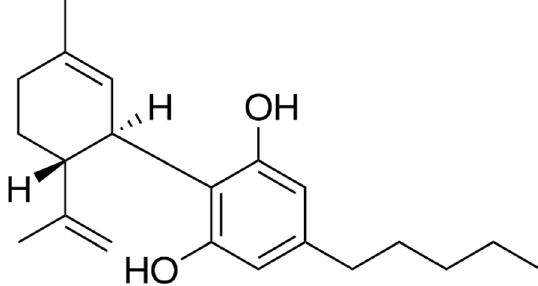
Figure 1. Chemical structure of CBD.